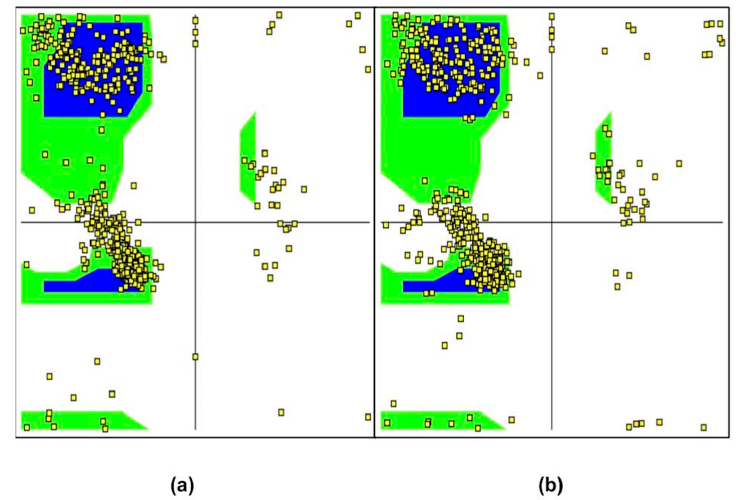
Figure 6. Ramachandran Plot in the ( a ) absence and ( b ) presence of GO. Blue and green regions indicate the favorable and allowed regions of conformation on the NDPK enzyme. Little yellow squares indicate the individual amino acid residues. There are no drastic changes observed in the presence and absence of GO indicating that NDPK doesn’t lose its function while strongly interacting with